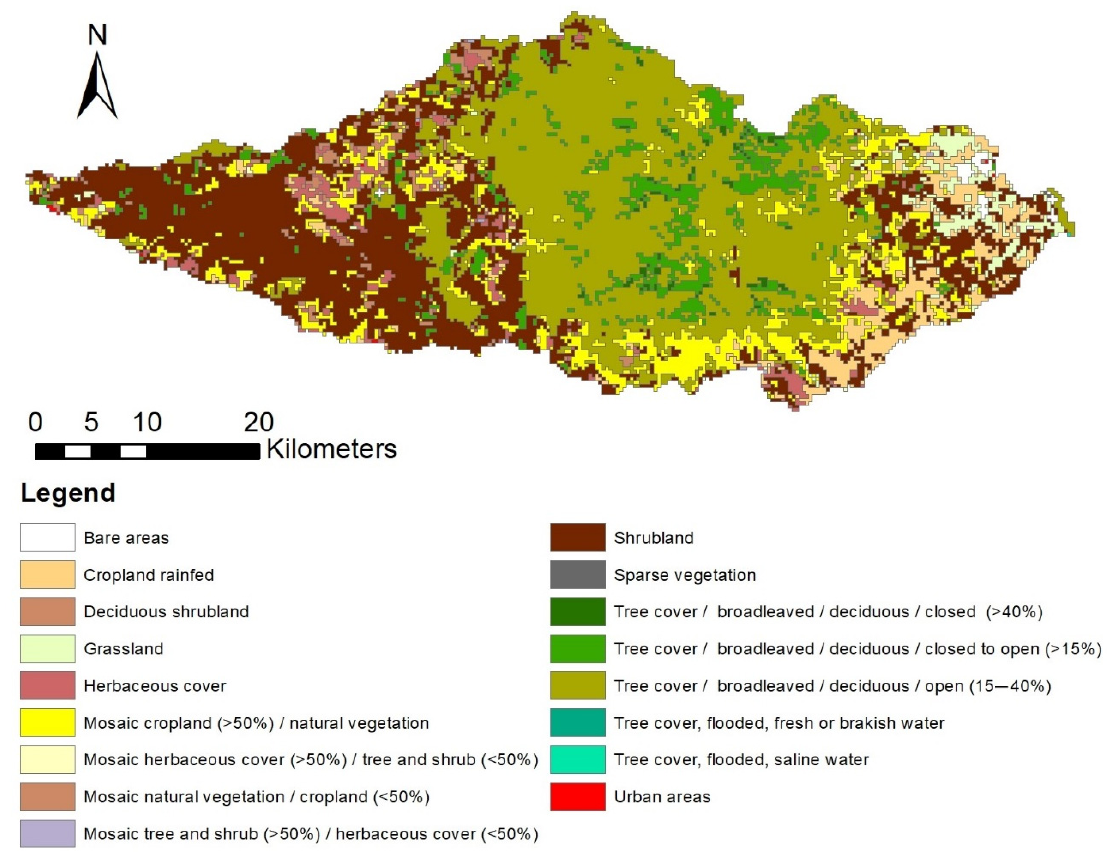
Figure 8. Soil cover map from